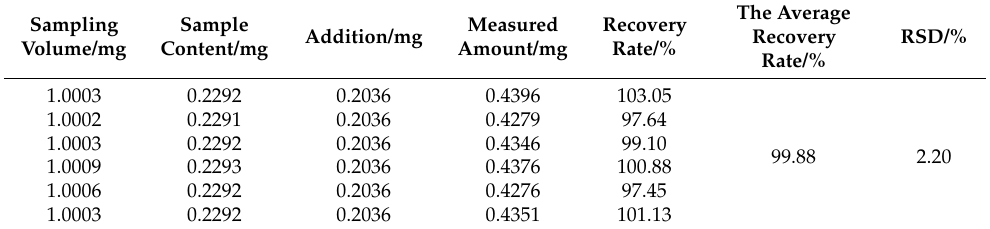
Table 3. Hesperetin sample recovery test